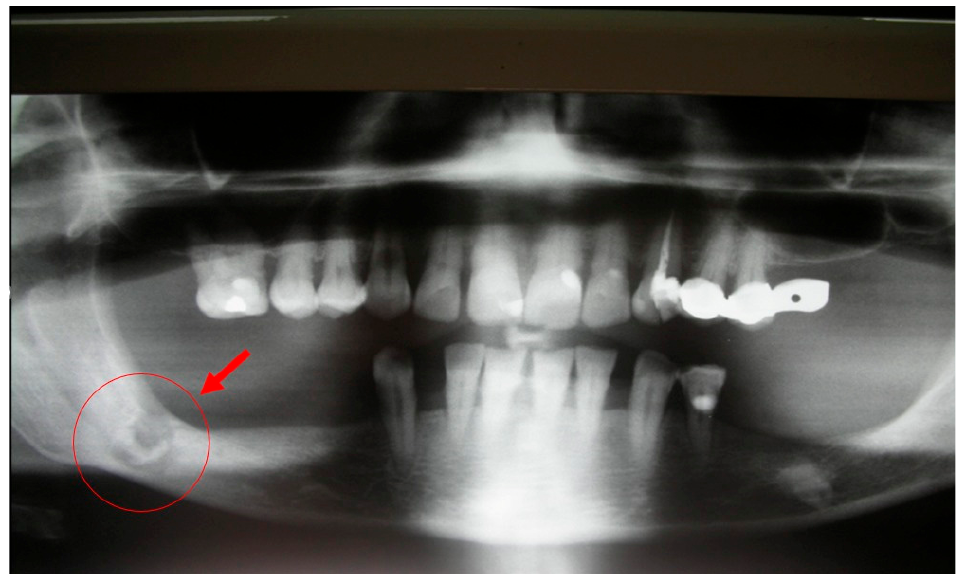
Figure 8. Initial lesion showed in OPT pointed by the circle.